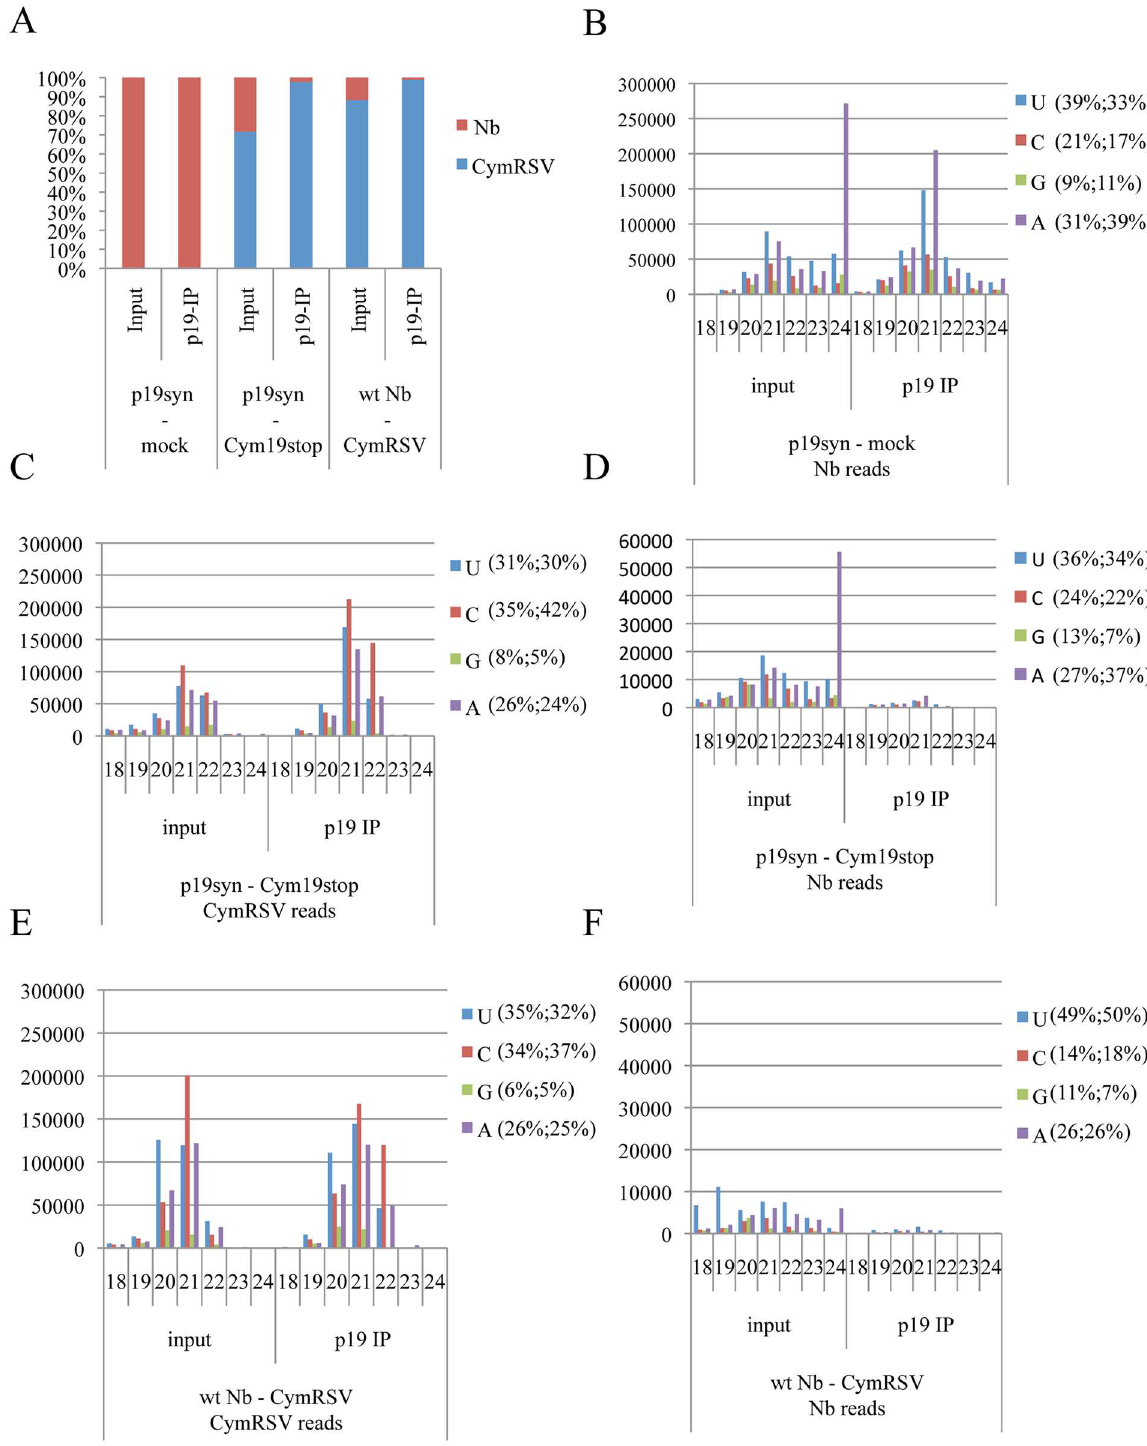
Fig 2. Endogenous and viral sRNAs sequestration preferencesof p19. (A) Total and p19-boundvsiRNAs and endogenous sRNAs derivedfrom N . benthamiana and p19syn plants infected with wt (CymRSV) and suppressor deficient Cym19stopviruses and mock-inoculated plants. (B) input and p19-boundendogenous sRNA duplexesin mock-inoculated plants. (C-F) inputs and p19-bound vsiRNAs and endogenous sRNAs when p19 was expressedin trans (C and D) or in cis (E and F) during virus infections as indicated.The size classes of sRNAs between 18 and 24nt are indicatedby numbers The 5’ nucleotides are indicatedby color codes.